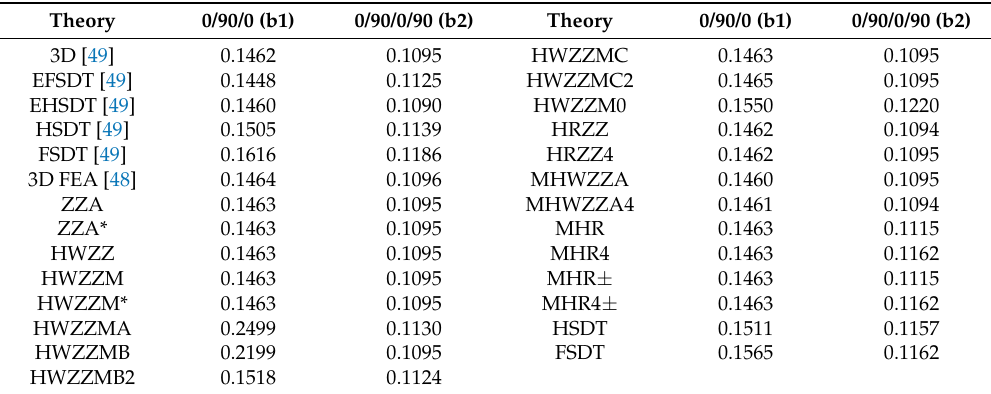
Table 6. Normalized fundamental frequencies, cases b1 and b2.